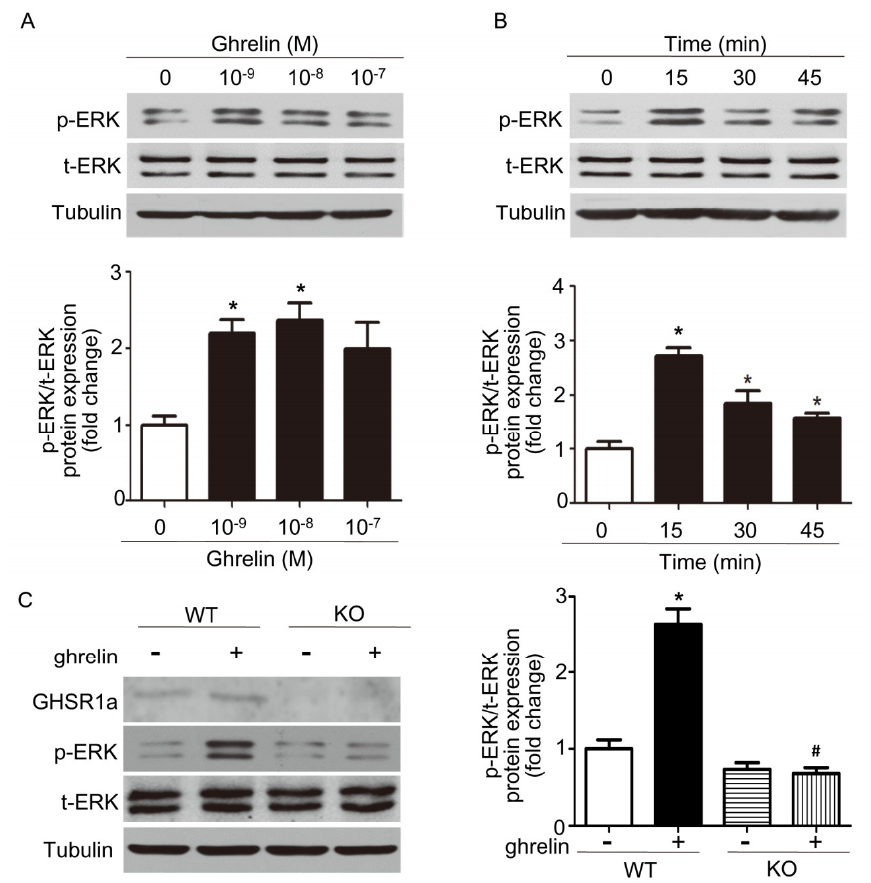
Figure 4. Ghrelin increases the phosphorylation of extracellular regulated protein kinases (ERK) in endothelial cells (ECs). ( A ) HUVECs were incubated with 10 −9 M, 10 −8 M, 10 −7 M ghrelin, or N.S. for 15 min, and the level of phosphorylated ERK or total ERK was determined by western blotting analysis. ( B ) HUVECs were incubated with 10 −8 M ghrelin or N.S. for 0 min, 15 min, 30 min, or 45 min, and the level of phosphorylated ERK or total ERK was determined by western blotting analysis. Data are expressed as mean ± SD from three independent experiments, each performed in triplicate (* p < 0.05 compared with control group). ( C ) EPCs from wild type and Ghsr − / − (KO) mice were incubated with 10 − 8 M ghrelin or N.S. for 15 min, and the level of phosphorylated or total ERK or GHSR1a was determined by western blotting analysis. Data are expressed as mean ± SD from three independent experiments, each performed in triplicate, * denotes p < 0.05 compared with EPCs from wild type mice without ghrelin administration, # denotes p < 0.05 compared with EPCs from wild type mice with ghrelin administration.